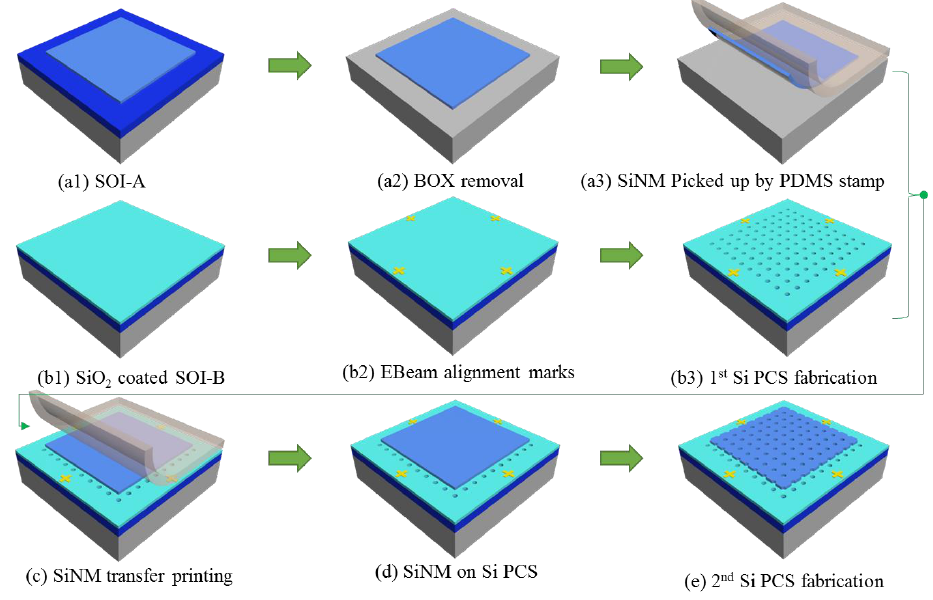
Figure 6. Schematic of double-layer lattice-shifted SiNM PCS fabrication